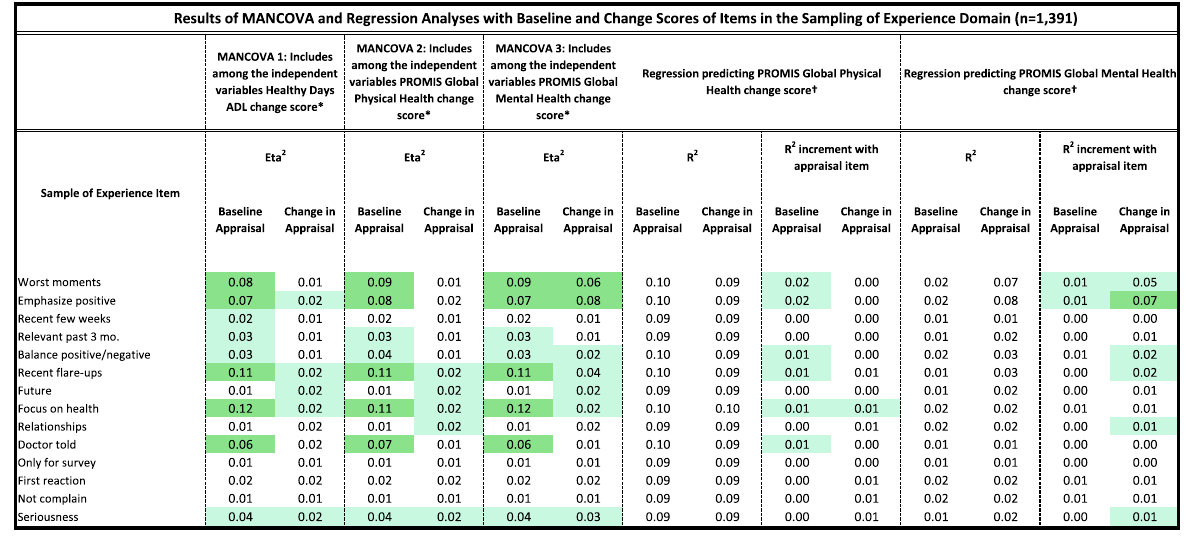
Table 4 Results of MANCOVA and Regression Analyses with Baseline and Change Scores of Items in the Sampling of Experience Domain ( n = 1391)